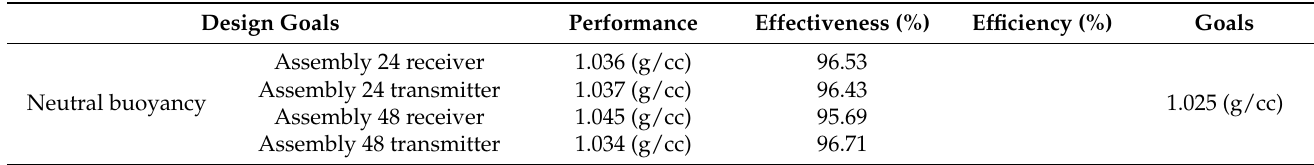
Table 10. Mechanical design buoyancy goals—visual scorecard.